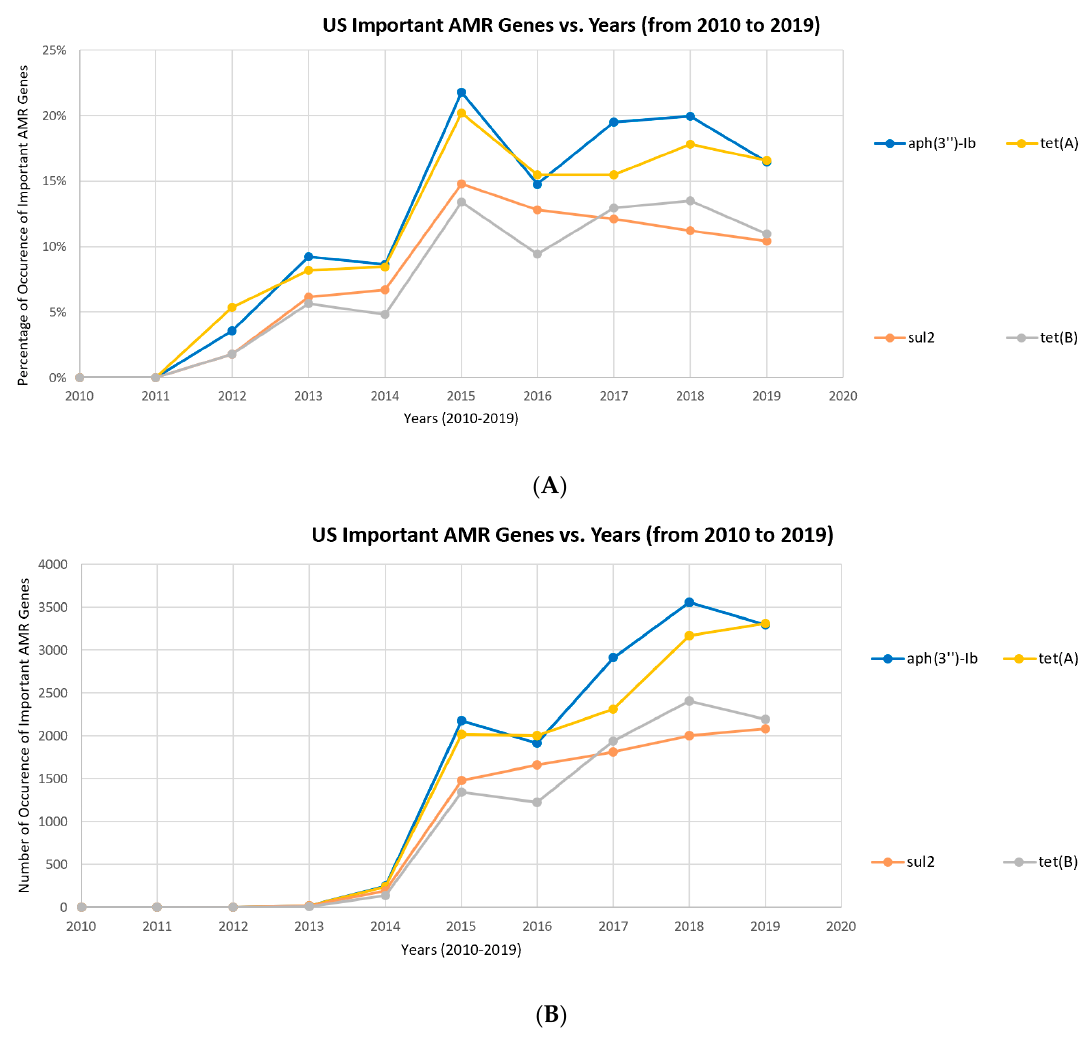
Figure 8. Frequencies of occurrence among the important AMR genes aph(3 ″ )-lb , tet ( A ), sul2 , and tet ( B ) between 2010 and 2019 in the US with ( A ) normalized and ( B ) absolute numbers of samples that contain the AMR